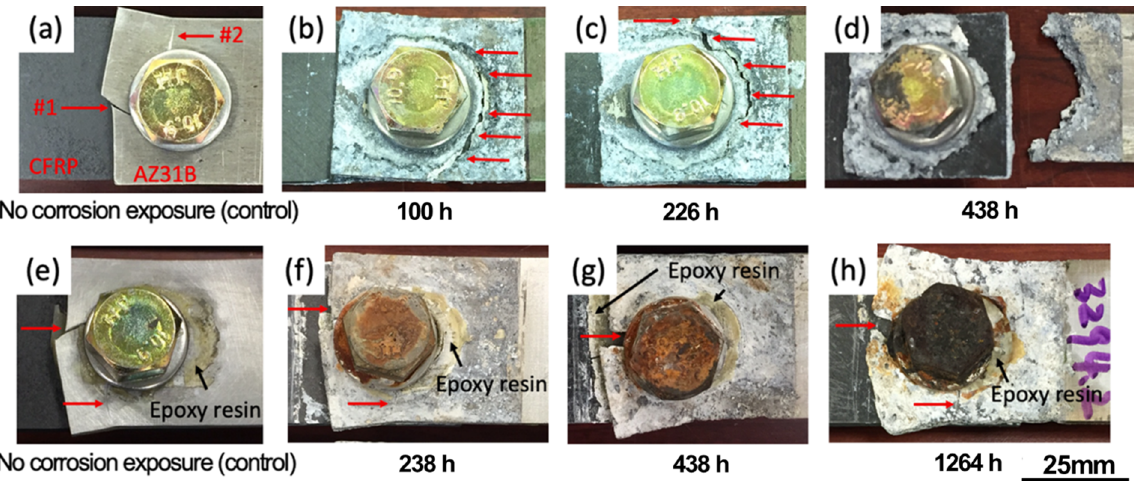
Figure 10. Comparison of fractography from lap shear tensile testing with different ASTM B117 exposure times for ( a – d ) bare and ( e – h ) polymer-insulated CFRC-AZ31B bolted joints. Red arrows indicate the failure locations on AZ31B, and black arrows show the epoxy resin overfill layer on the AZ31B surface.